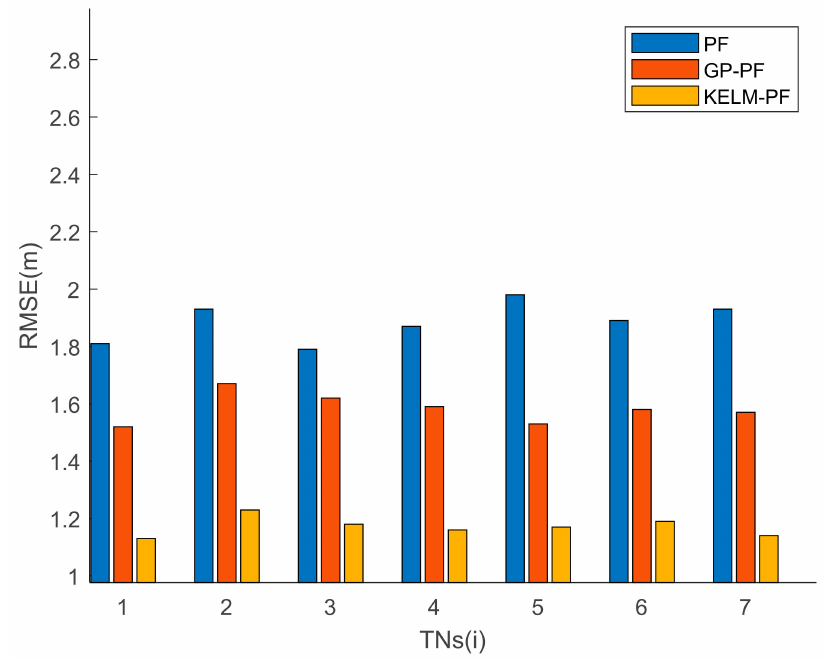
Figure 5. Positioning accuracies of different algorithms in room 520.